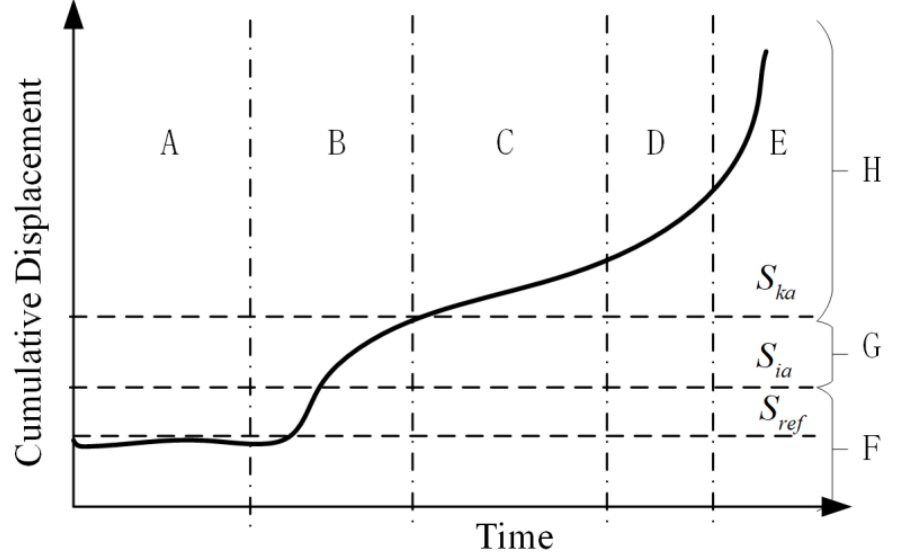
Figure 1. Refined landslide failure process. ( A ): Plateau stage, ( B ): Initial deformation stage, ( C ): Constant deformation stage, ( D ): Accelerated deformation stage, ( E ): Critical sliding stage, ( F ): normal zone, ( G ): initial attention zone, ( H ): key attention zone.